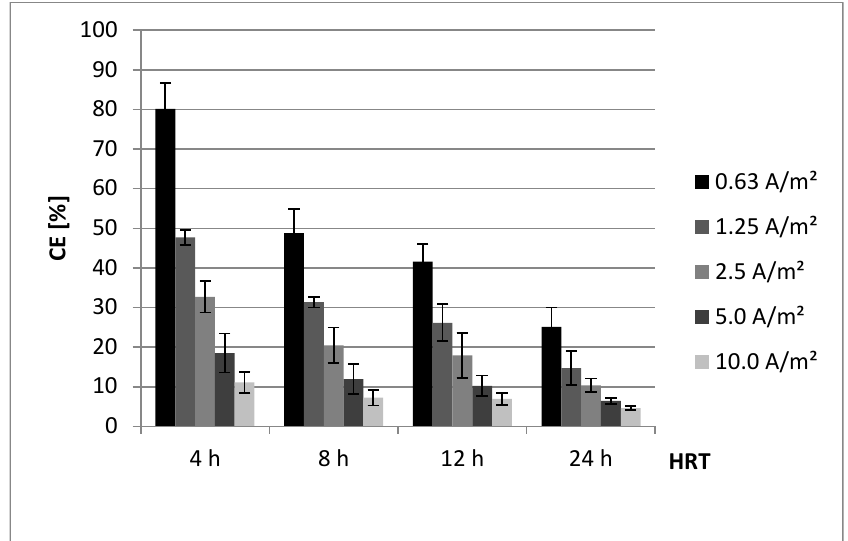
Figure 3. Current efficiency (CE) of the rotating electrobiological disk contactor (mean and standard deviation).